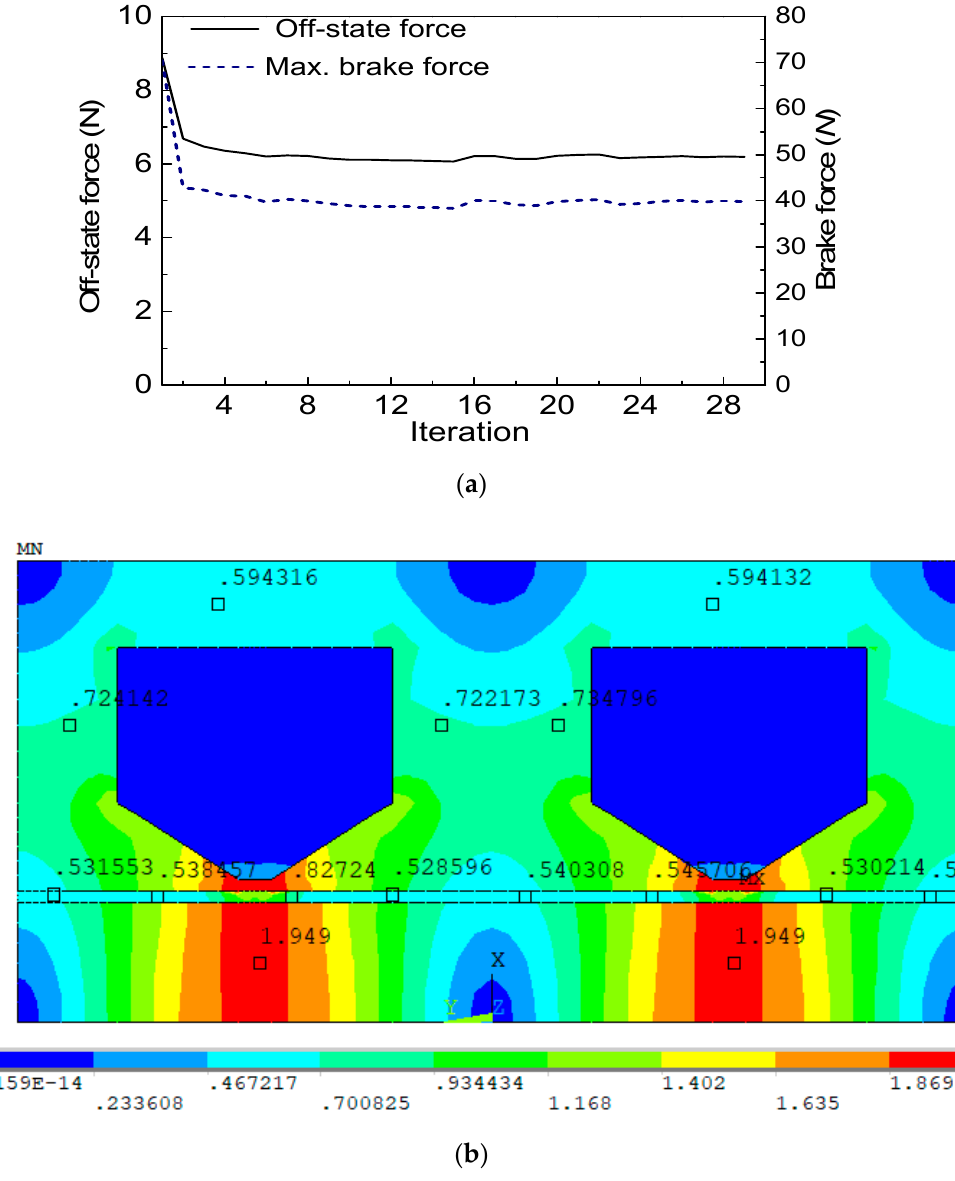
Figure 10. Optimization solution of the linear MR brake. ( a ) Mass and braking torque. ( b ) Magnetic flux density of the brake at the optimum.